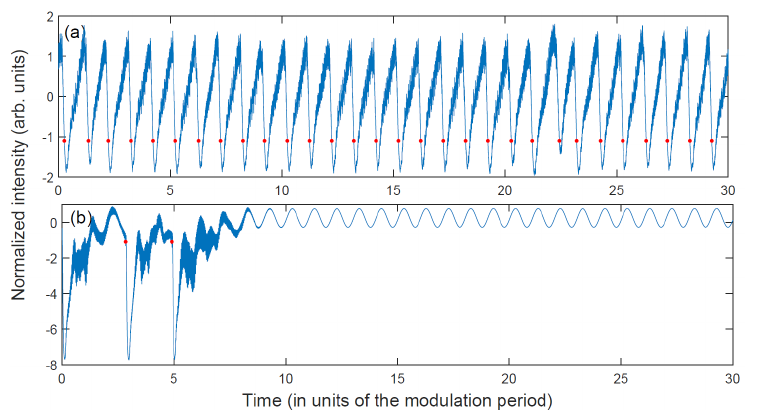
Figure 6. Intensity time series displaying ( a ) 1:1 locked spikes ( f mod = 16 MHz, a mod = 0.012); ( b ) transient spiking dynamics followed by periodic oscillations ( f mod = 6 MHz, a mod =